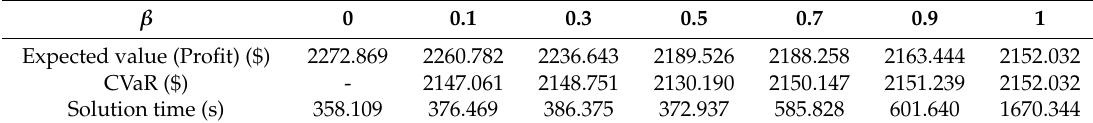
Table 9. Risk aversion parameter effect and solution time.